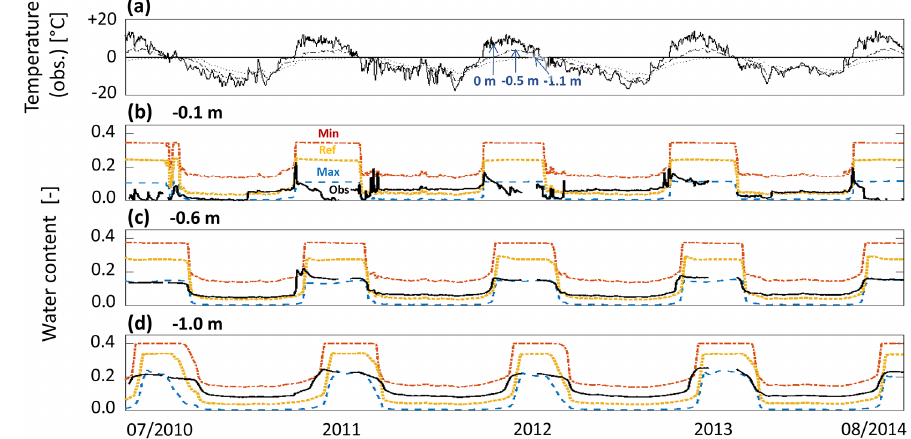
Figure 4. (a) Daily measured ground temperatures on the surface 0m (solid) and at depths 0.5m (dashed) and 1.1m (dotted) between July 2010 and August 2014. Also volumetric water content at depths (b) 0.1m, (c) 0.6m, and (d) 1.0m as observed (solid black) and modelled (showing ref case, min case and max case in yellow, red and blue respectively). The remaining simulation cases (not shown) reside within the limits of the min and max